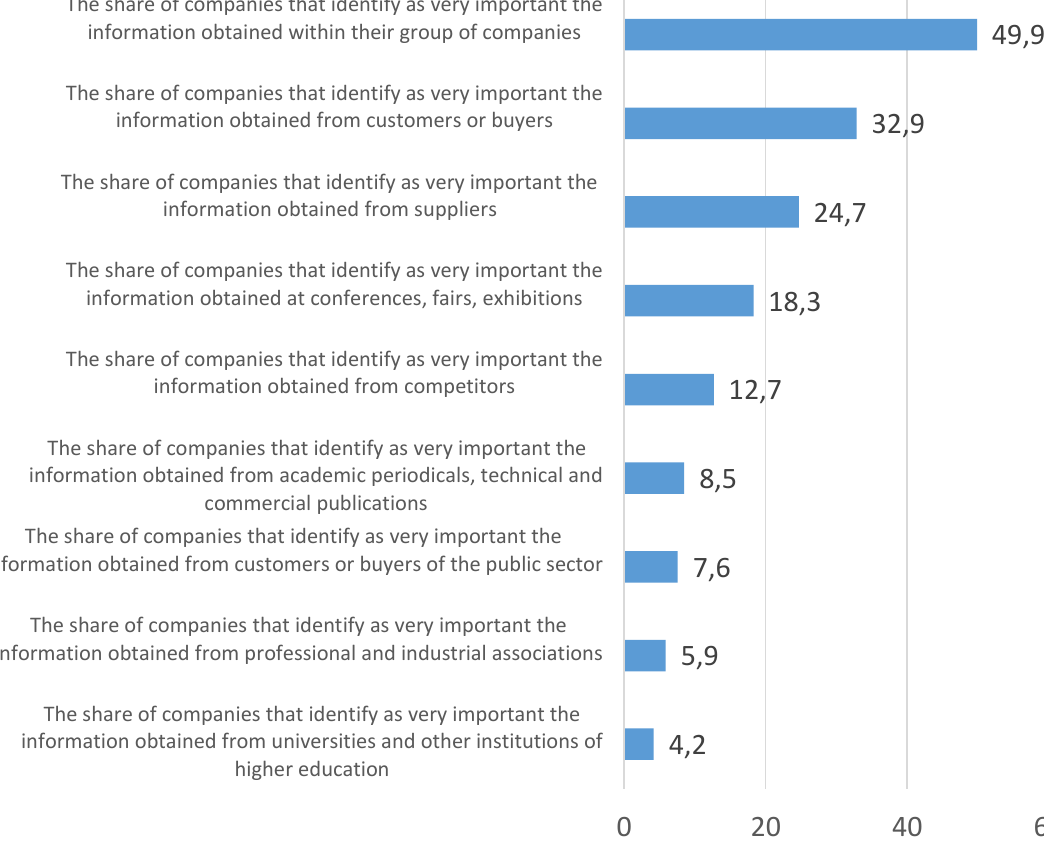
Figure 3. The most important sources of information for light industry companies of the EU